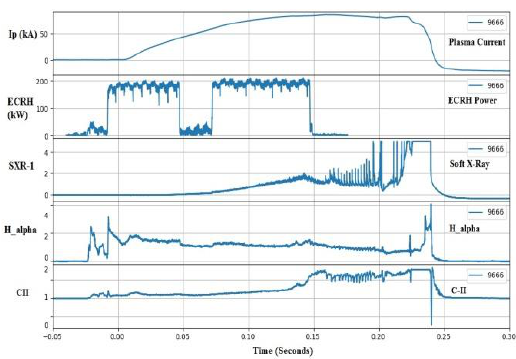
Fig. 1. SST-1 plasma shot with two ECRH pulses